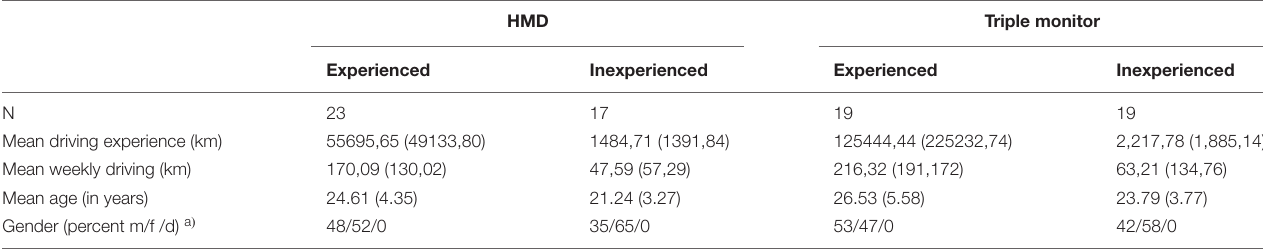
a ) m, male; f, female; d,